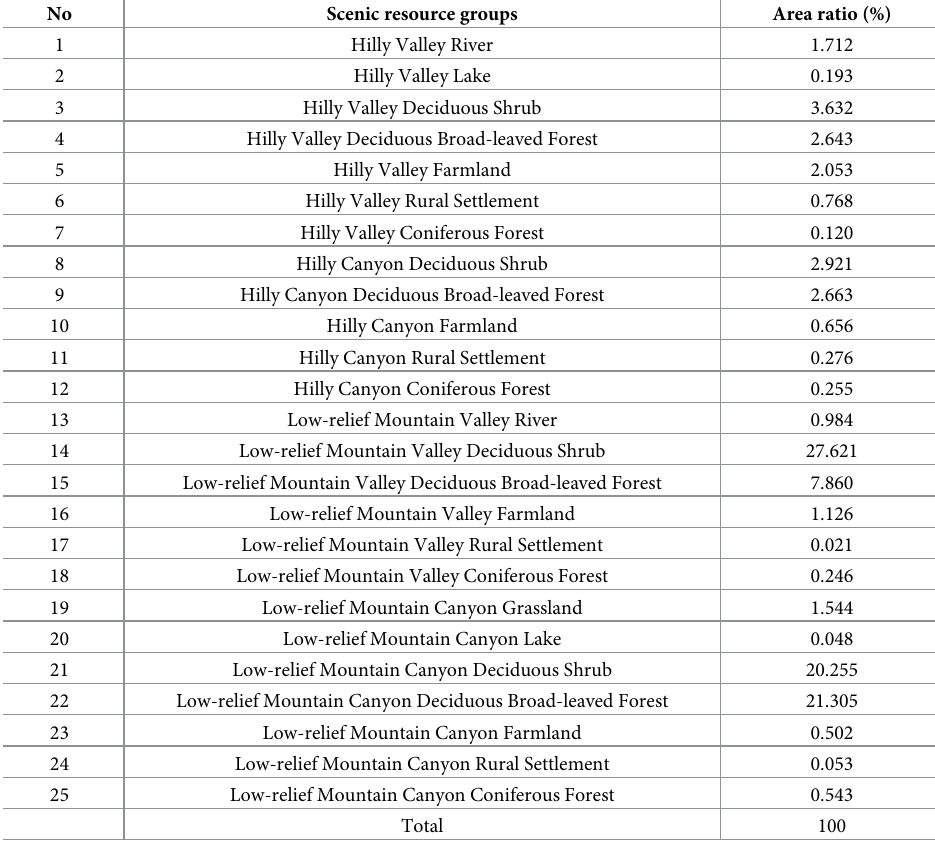
Table 5. Scenic resource groups in canyon/river valley of the hilly area.